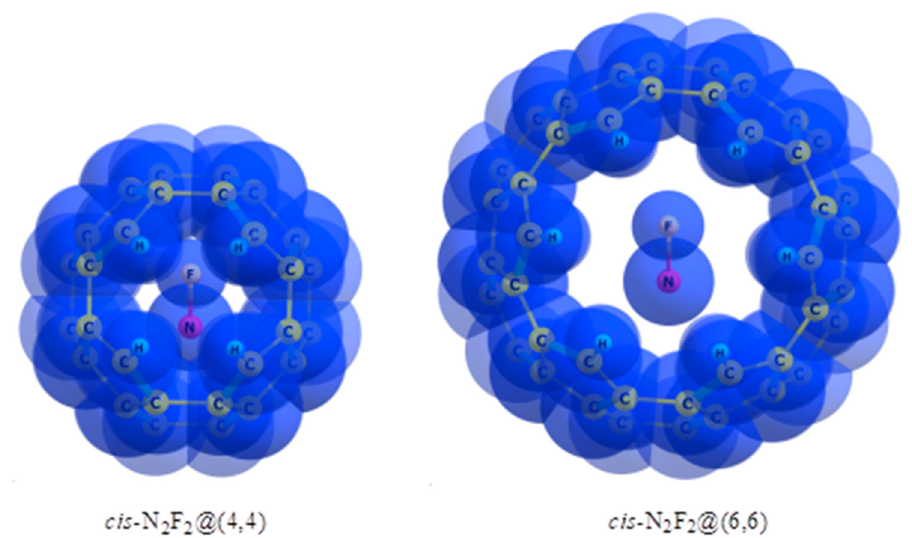
Figure 20. Clusters of cis-N 2 F 2 in the light of van der Waals spheres. The distances between the guest molecule and the SWCNT wall are 2.4 Å and 3.7 Å for (4,4) and (6,6) endocomplexes, respectively. Adapted with modification [267].